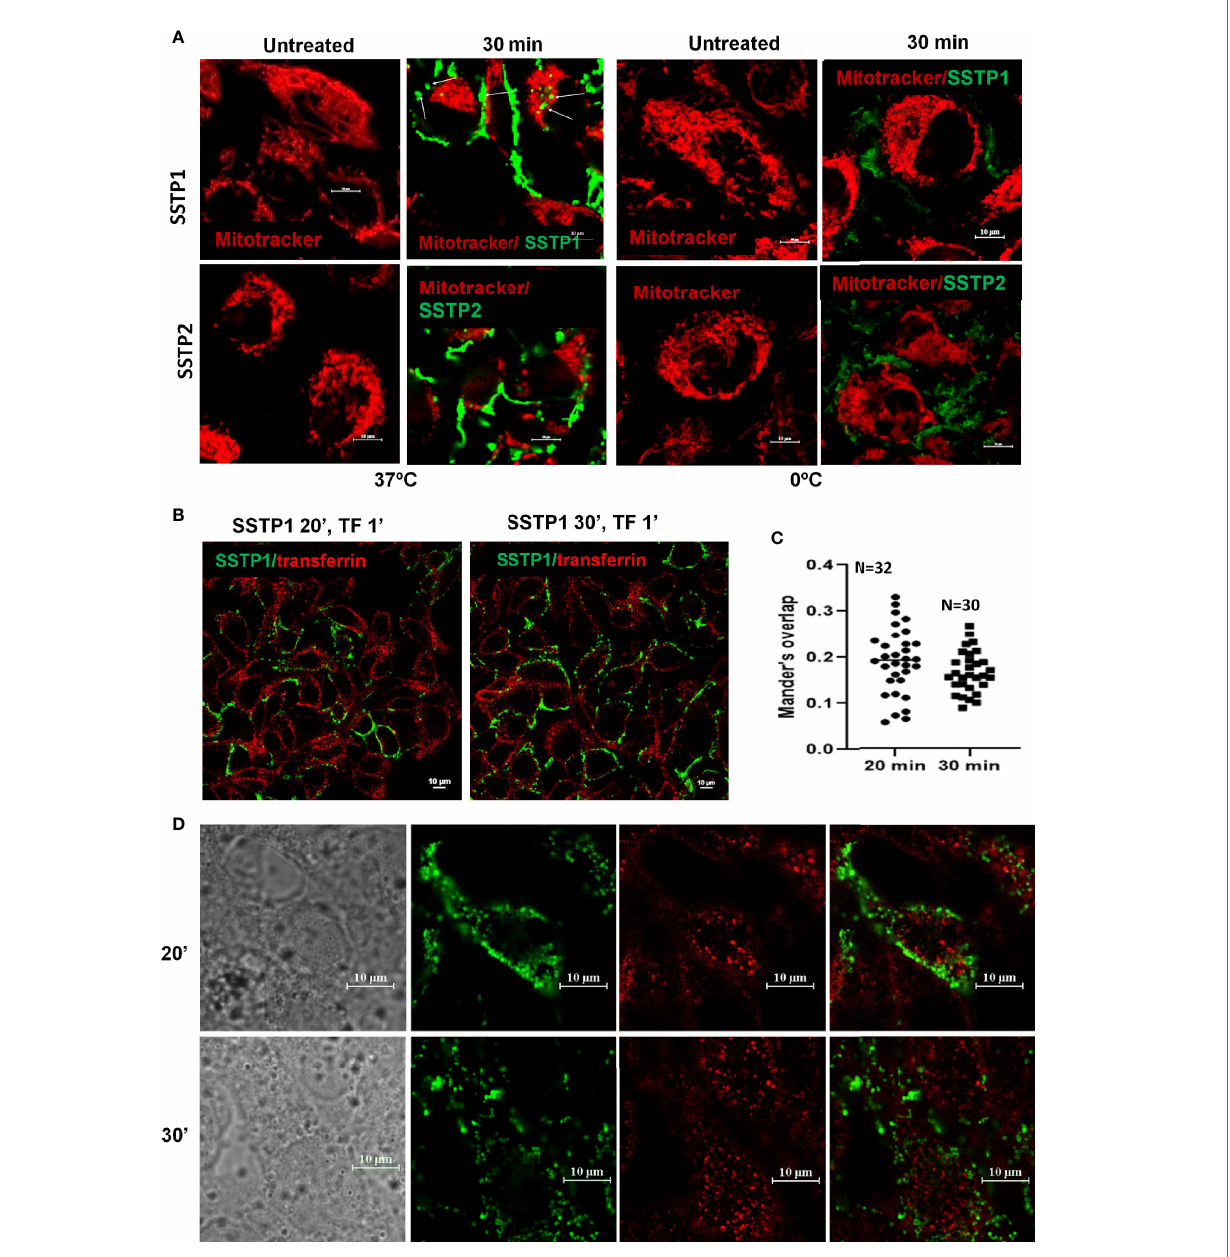
FIGURE 2 | SSTP1 is internalized by active uptake. (A) Live HSC-4 cells were incubated with MitoTracker Deep Red and incubated for 10 min. Excess dye was washed off, and then the respective peptides were added, which were labeled with Alexa Fluor-488, and incubated either on ice or at 37°C. The unbound peptide was washed off and the images were acquired at the indicated time intervals. The arrowmarks indicate the internalized peptide. Magni fi ed images along with DIC are provided in Supplementary Figure 3 . (B) The cells were treated with Alexa Fluor-488-labelled SSTP1 for indicated time and Alexa Fluor-568-labelled transferrin was added and incubated for one minute. The cells were washed, fi xed and imaged. (C) The extent of co-occurrence for panel B was measured and plotted as Manderson ’ s overlap. The median value is shown in the graph. (D) The high magni fi cation representative images of (B) The scale bars represent 10 m